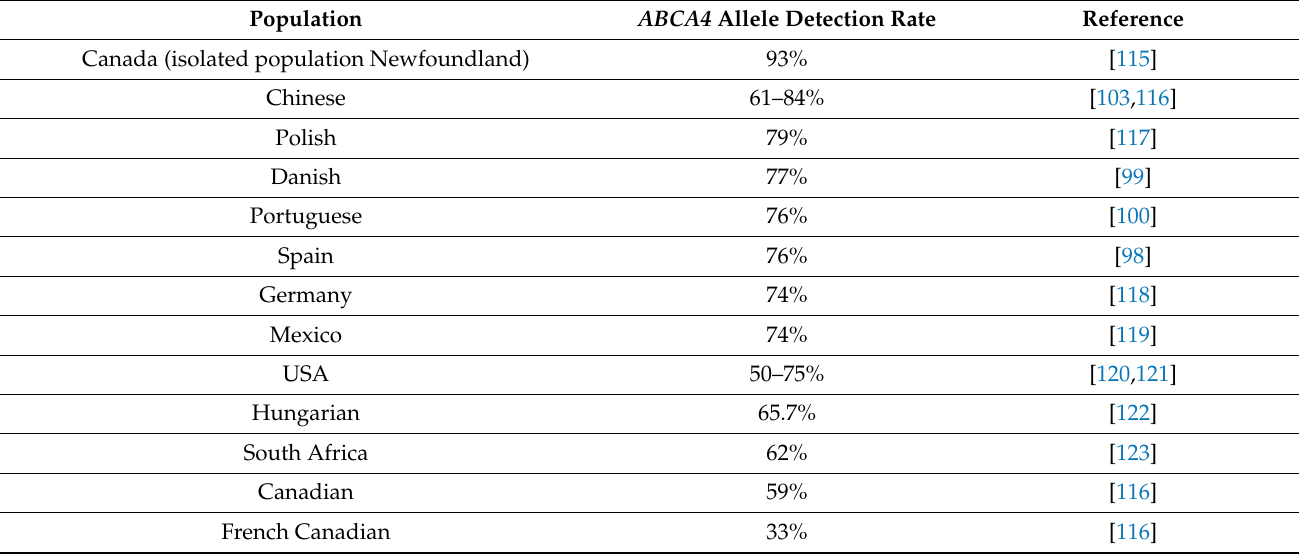
Table 2. The detection rate of ABCA4 variants in patients with an STGD1 phenotype in different populations. Population ABCA4 Allele Detection Rate